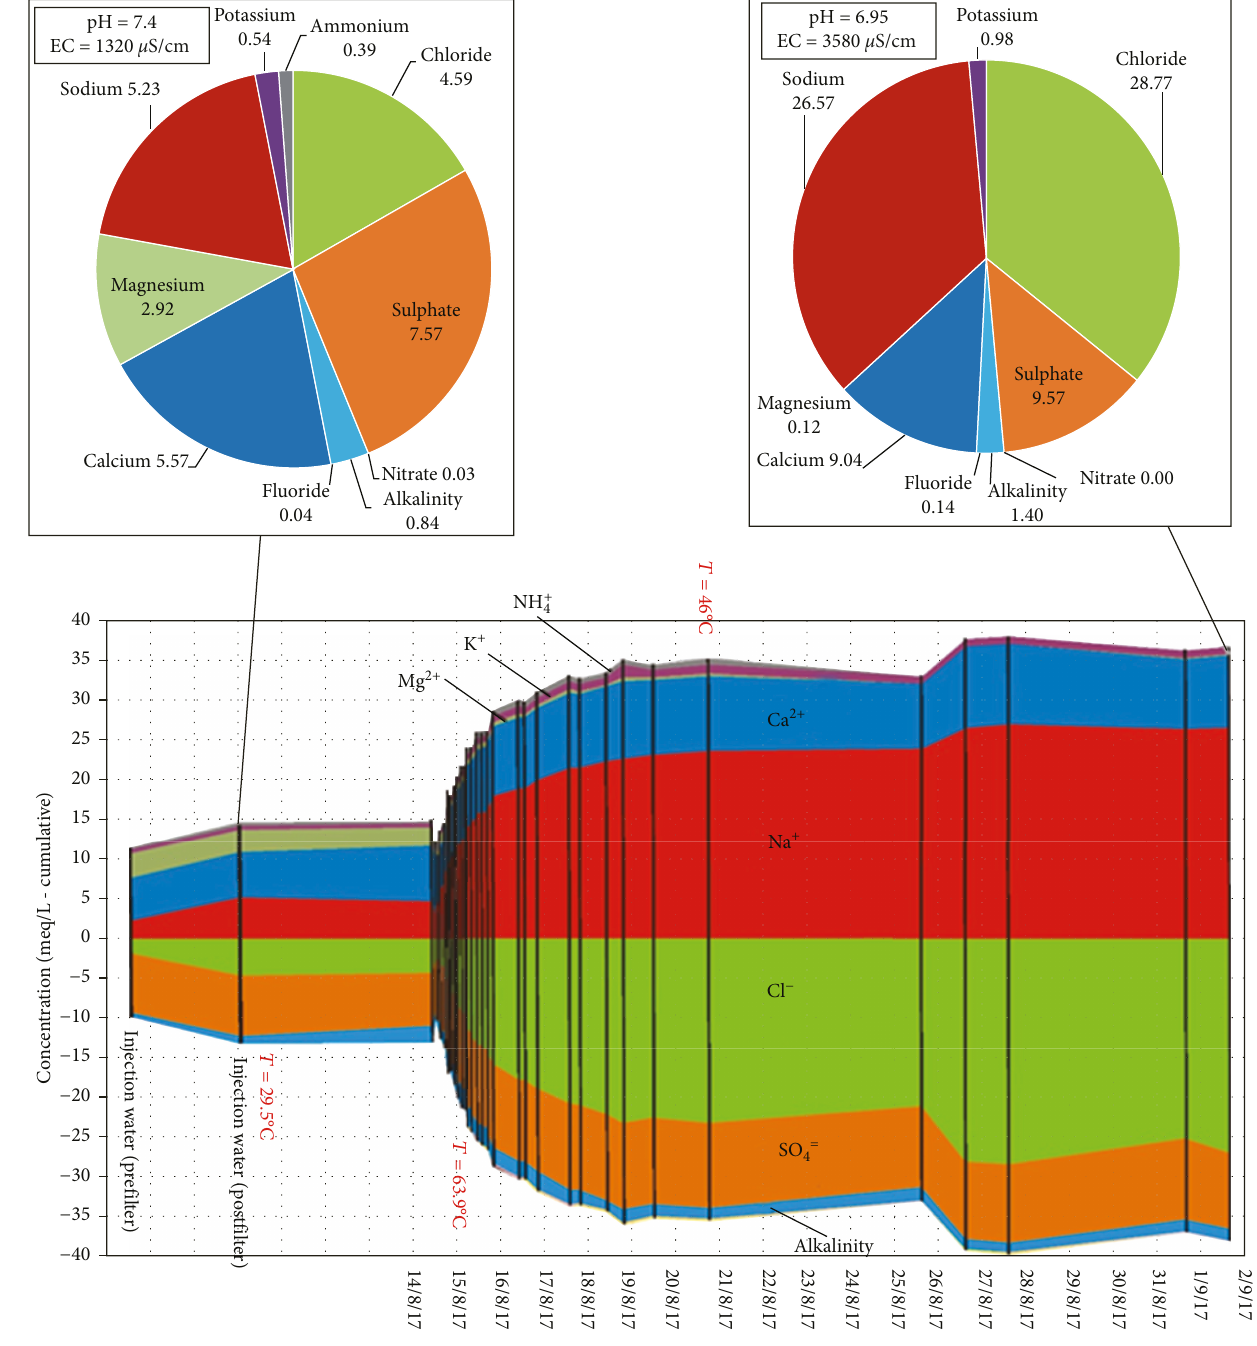
Figure 8: Summary of variations over time in the composition and other properties of the water injected into, and subsequently produced from, well PX-1 in August 2017, using data from the supplementary fi